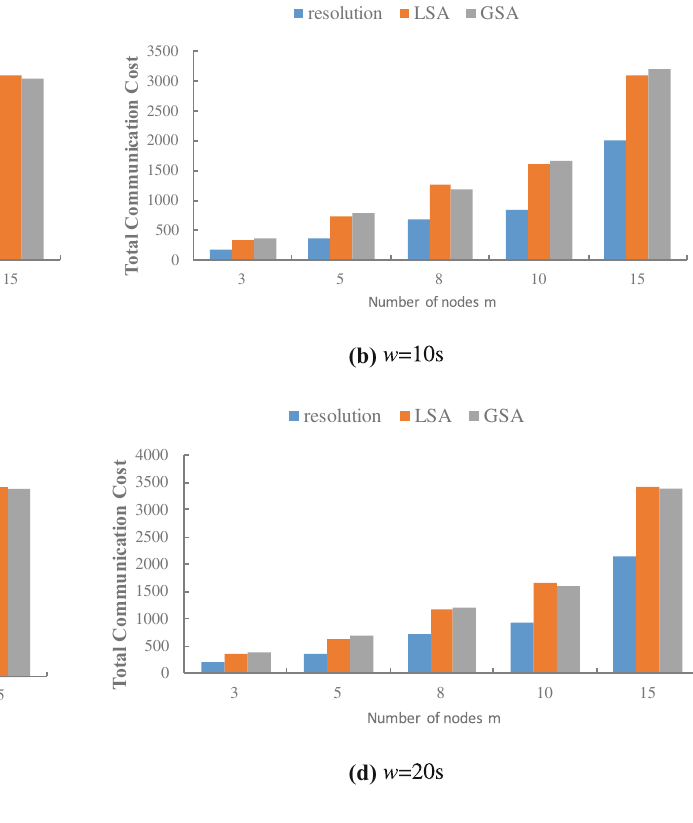
Fig. 4 Varying number of nodes m using synthetic